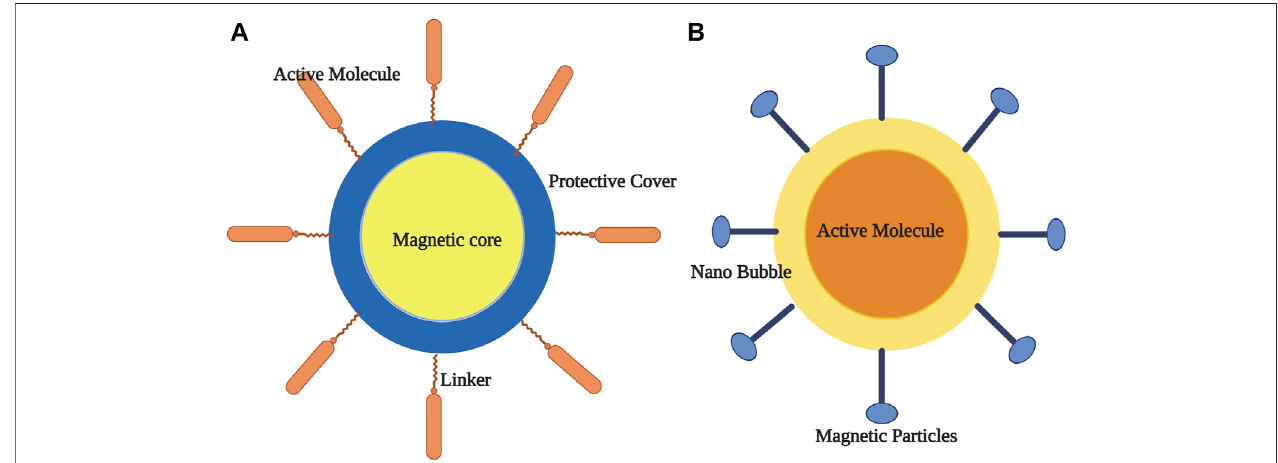
FIGURE 1 | Methods of preparation of